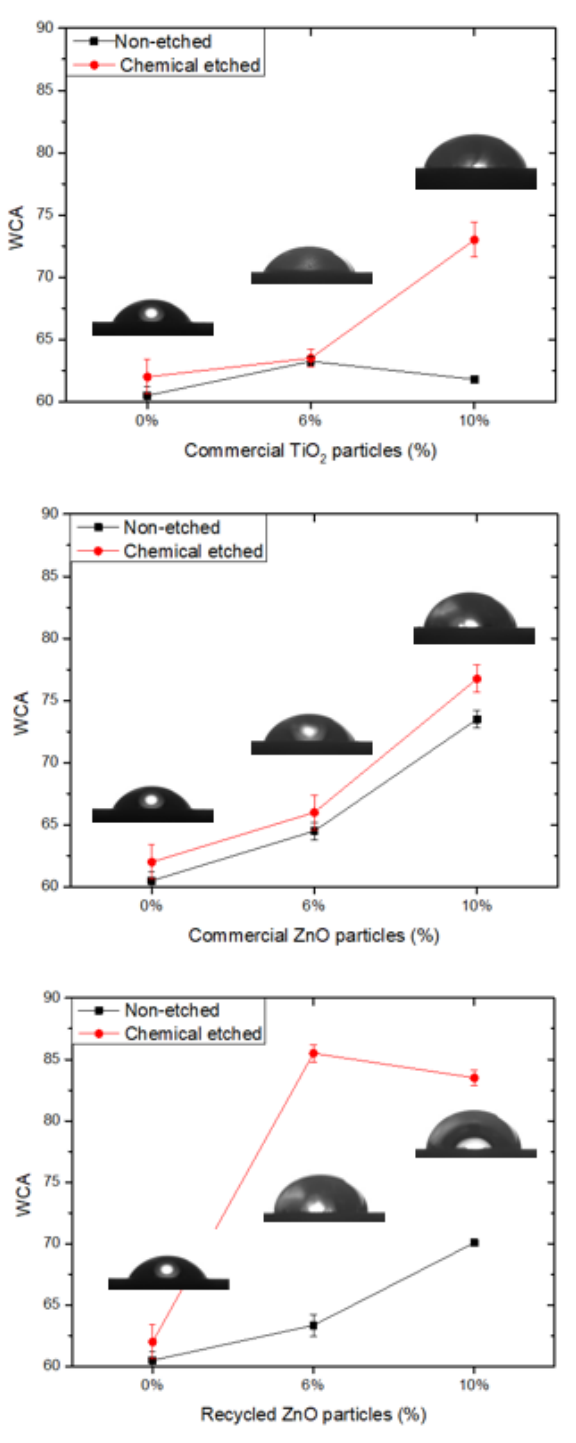
Figure 6. Static water contact angle (WCA) of chemically etched and non-treated composites and epoxy thermoset surfaces. The drop images correspond to etched surfaces.